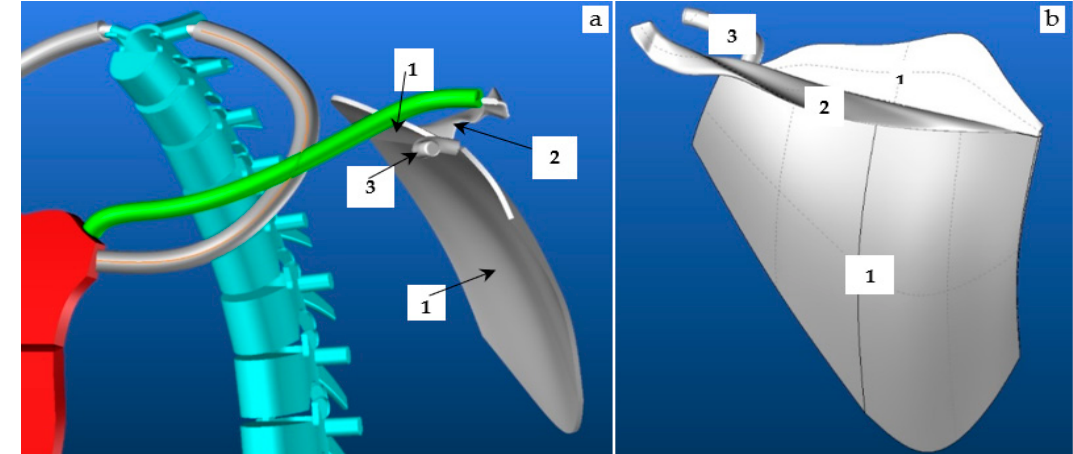
Figure 10. The rib R1, sternum, clavicle, scapula ( a ) and scapula ( b ) of the vertebra.